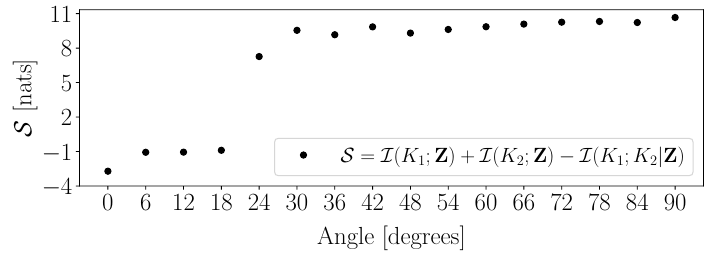
Figure 9. Information criterion against the angle when the protocols are restricted to a maximum of one